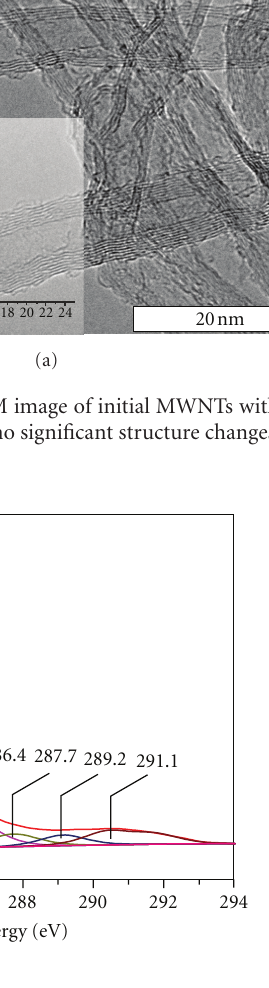
Figure 2: XPS C1s spectrum for both initial and brominated sam- ples and its decomposition on individual